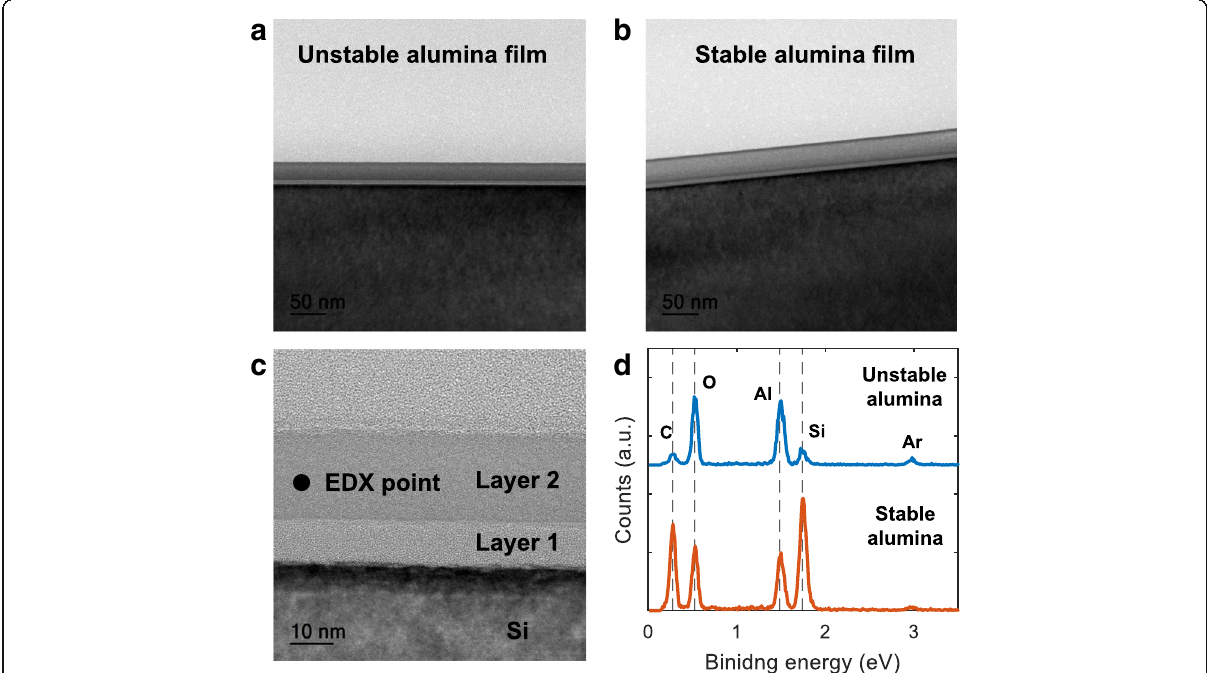
Fig. 3 a Cross-sectional TEM images of the unstable alumina film. b Cross-sectional TEM images of the stable alumina film. c High-resolution TEM image of the unstable alumina film that shows two different layers of the alumina film. d EDX spectra detected from the middle of the film